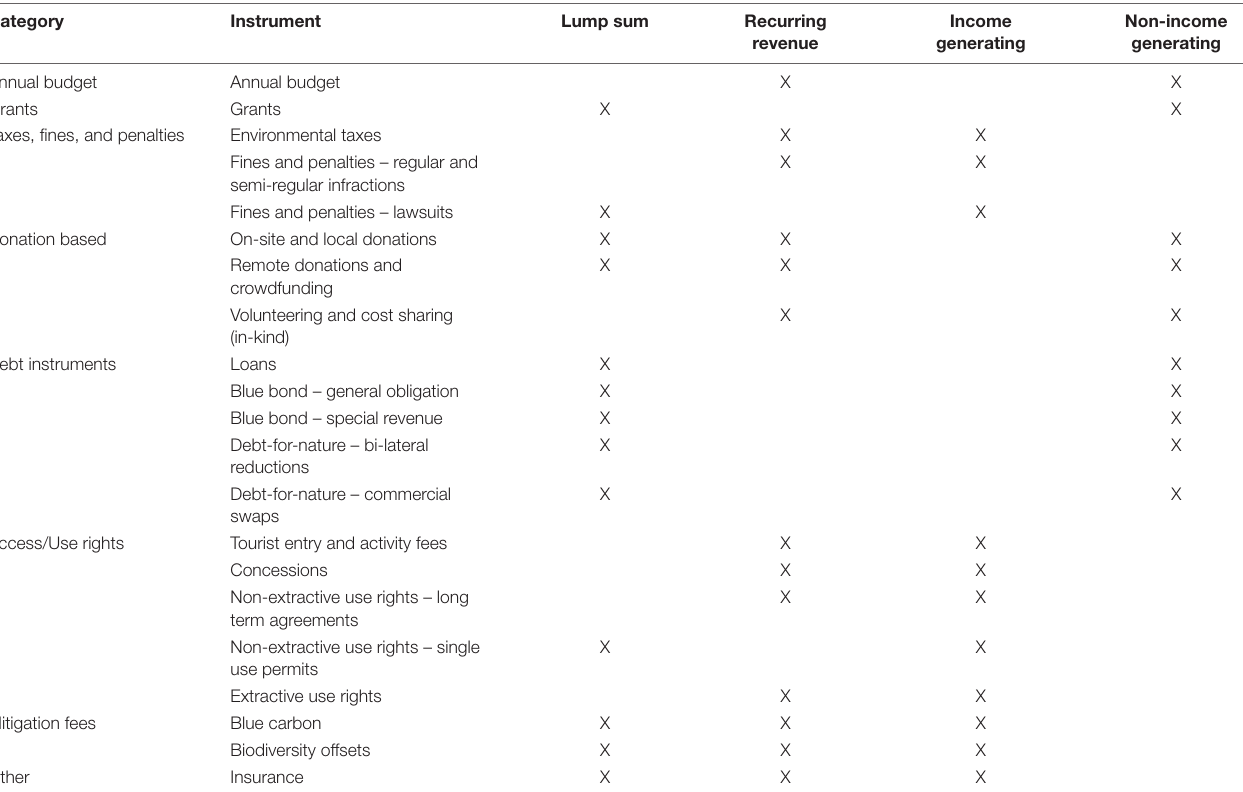
TABLE 2 | Organization of financial instruments by lump sum vs. recurring revenue, and income generating vs. non-income